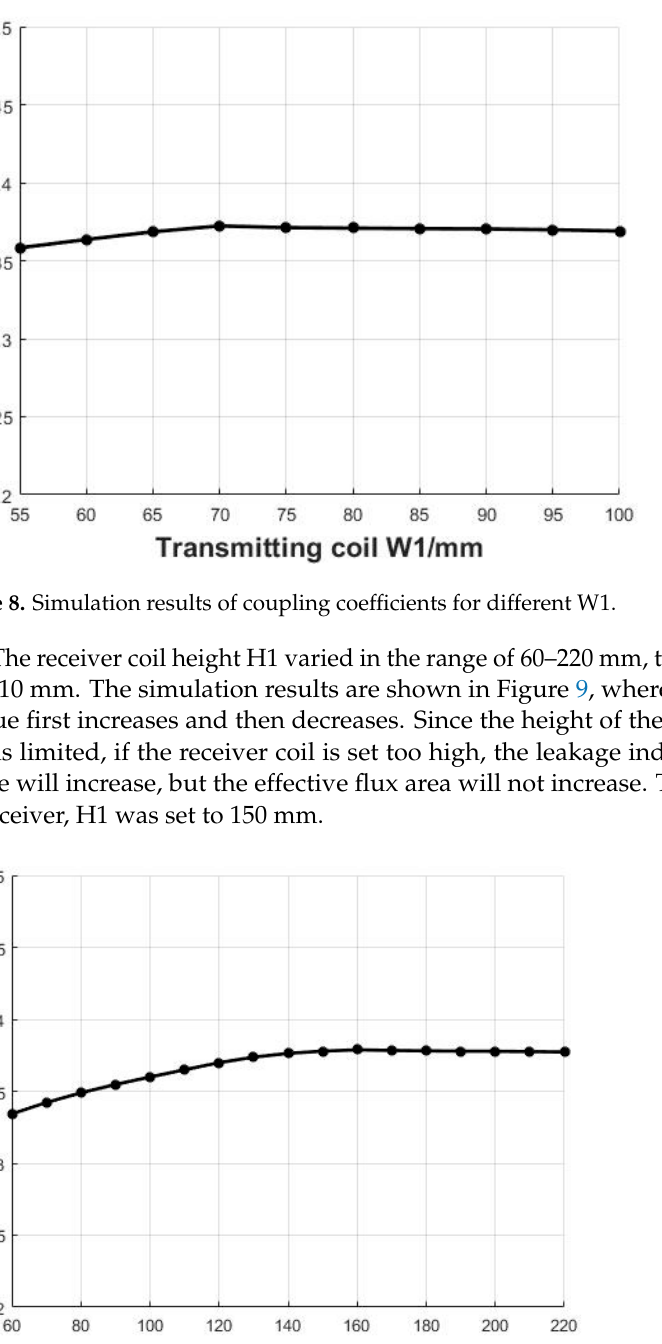
Figure 9. Simulation results of coupling coefficients at different H1.